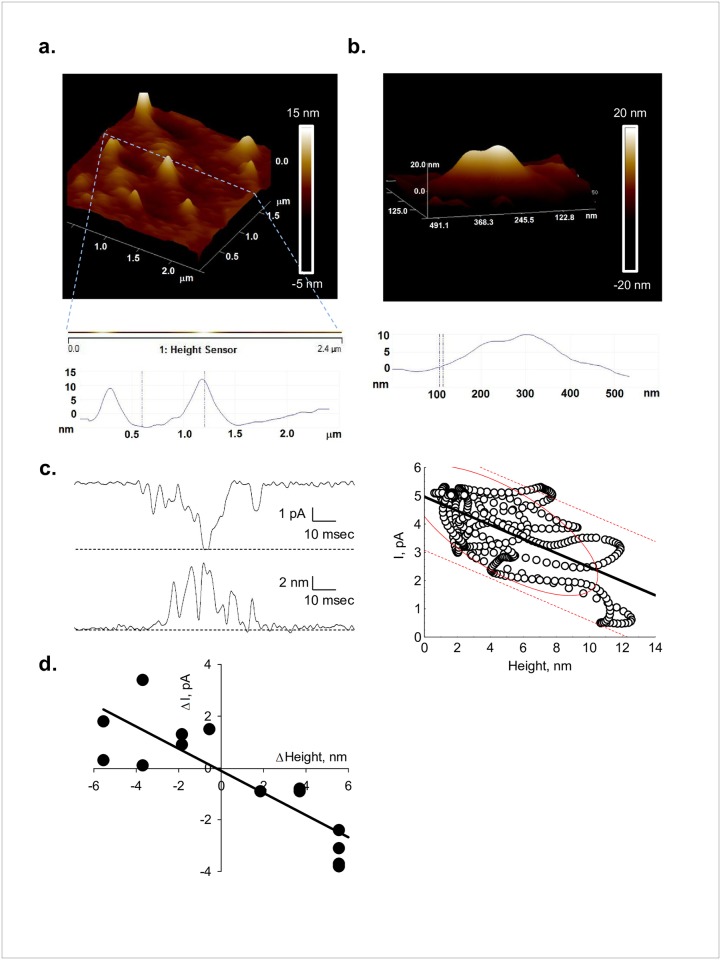
Electrical and topological correlates from single line scans of PC2.a. (Top) Large BLM scan (2.4 x 2.4 μm) used to locate single channel complexes (white peaks). Dashed line indicates position of fast one-line scanning. (Middle) Enlarged two-line scan to show location of channel complexes in the image. (Bottom) Height profiles of two channel complexes traversed by the scan line. b. Smaller scan (500 x 500 nm) showing an identified single channel complex and corresponding height profile (below). c. Left. Short single channel current tracing (110 msec) showing sub-conductance levels (Top) and corresponding height profile obtained from simultaneous single-line scans (Bottom). Right. Correlation between height and current amplitude (dashed red lines indicate data ellipse and regression bands with 95% confidence interval). d. Changes in relative height and current amplitude respect to the longer dwell time for each scan (see text), obtained for another channel complex again showing an inverse linear correlation.